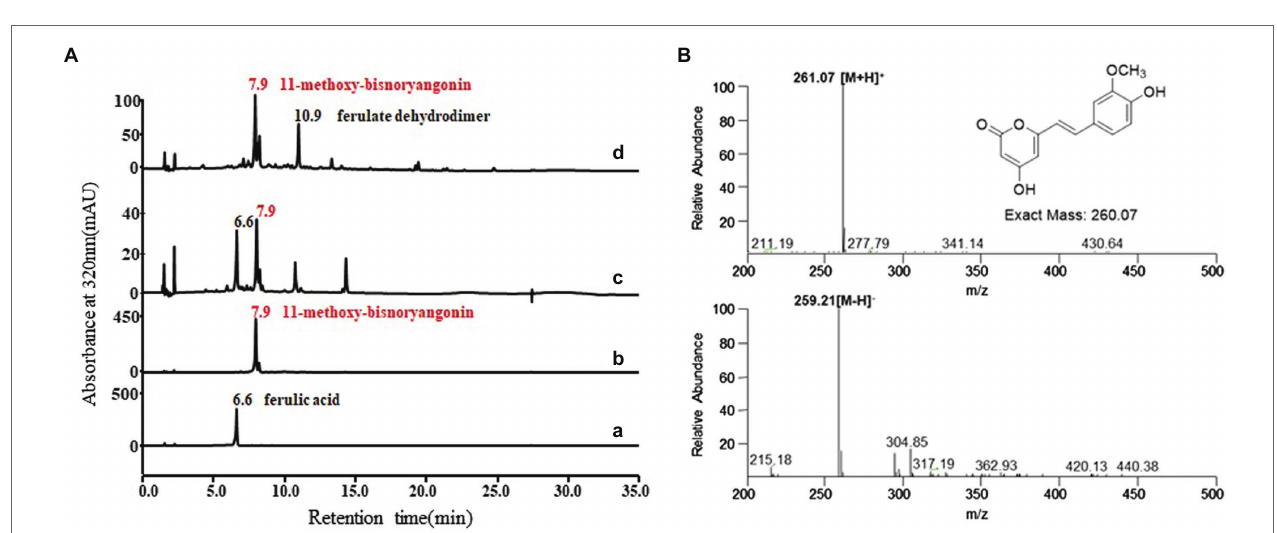
FIGURE 4 | Functional analysis of PnPKS using in vitro enzymatic reaction and bioconversion experiment with ferulic acid. (A) HPLC profile of the standard ferulic acid (a), purified 11-methoxy-bisnoryangonin (b), in vitro reaction (c), and ferulic acid supplemented E. coli harboring pET22-4P (P1; d). The absorbance was monitored at 320 nm. (B) Selected mass ion chromatogram of peak at 7.9 min (trace c) exhibited m / z 261 [M+H] + and m / z 259 [M − H] − ,which corresponded to 11-methoxy-bisnoryangonin. Peak at 10.9 min (trace d) exhibited m/z 371 [M+H] + , which corresponded to dimerized ferulic